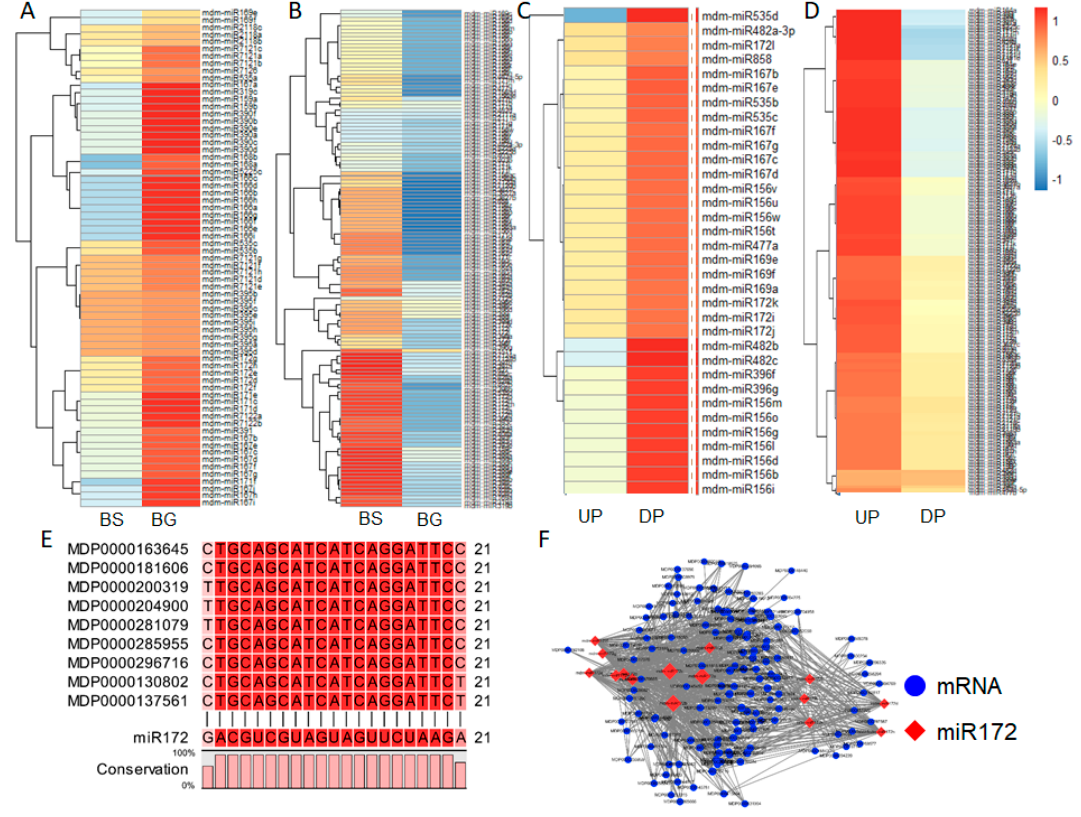
Figure 6. Heatmap analysis of differentially expressed miRNAs: ( A ) upregulated differentially expressed miRNAs in BS and BG; ( B ) downregulated differentially miRNAs in BS and BG; ( C ) upregulated differentially expressed miRNAs in UP and DP; and ( D ) downregulated differentially expressed miRNAs in UP and DP; ( E ) multiple alignment of miR172 target sites of AP2 gene family; ( F ) target network of miRNA172 family with its target genes.